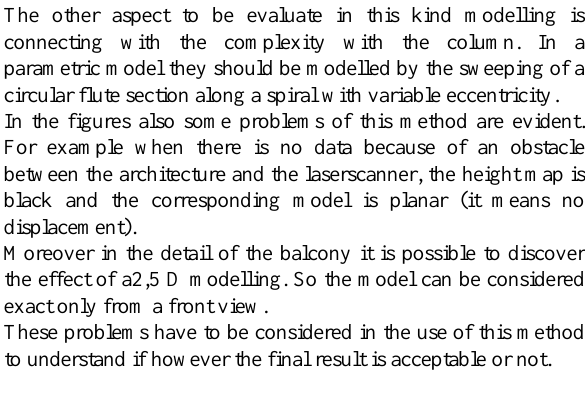
Figure 6. Detail of the façade where it’s possible to identify different kinds of the superficial